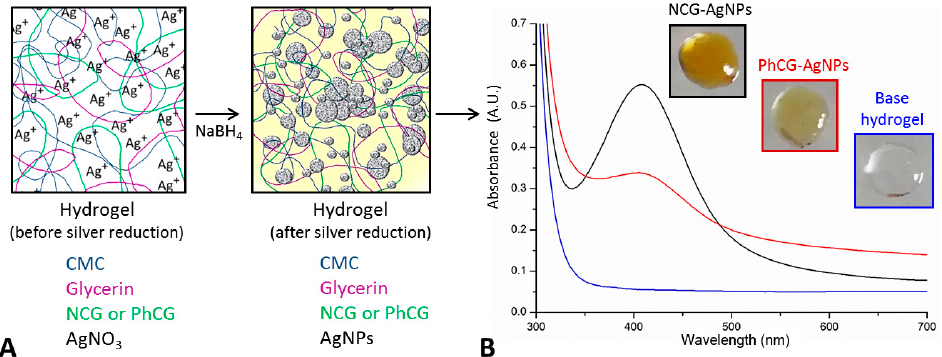
Figure 3. ( A ) Scheme of the in situ synthesis of silver nanoparticles (AgNPs), using cashew gum (CG) and PhCG; ( B ) UV-Vis spectra and photographs of NCG-AgNPs and PhCG-AgNPs.